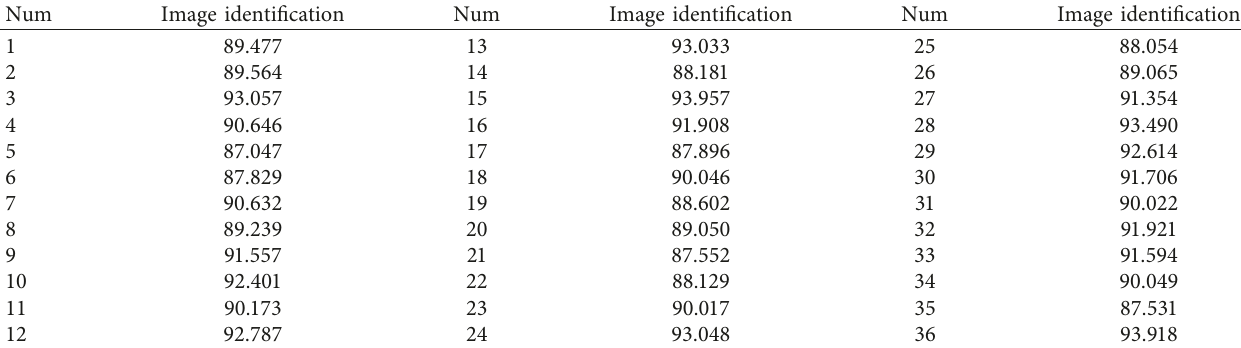
Table 1: Image recognition effect of college English teaching based on VR technology and AI technology. Num Image identification